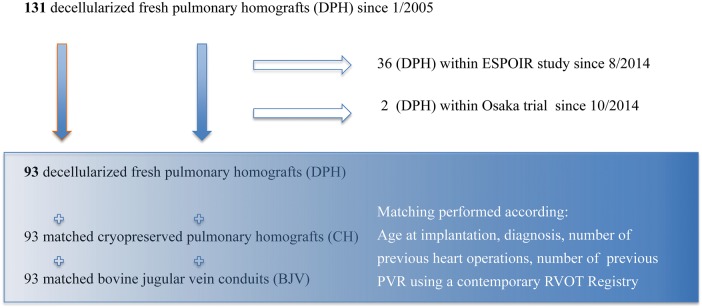
Study cohort overview.